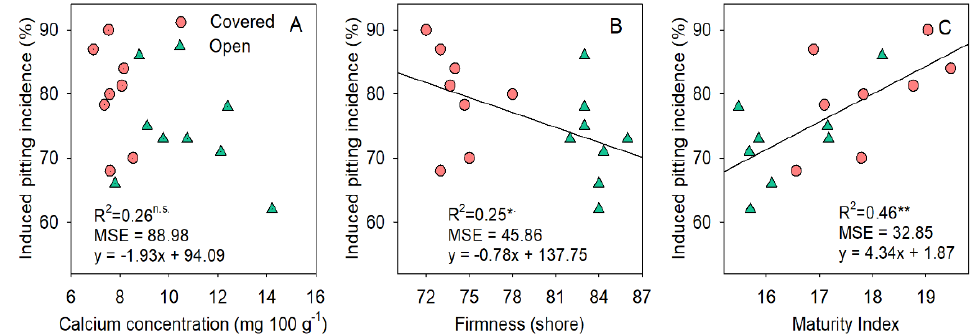
Figure 4. Relationships between induced pitting of ‘Santina’ sweet cherries from trees under high tunnels and those in the open in the Central Valley of Chile, season 2019/2020, after 14 d of cold storage, and Ca concentration ( A ), fruit firmness ( B ), and maturity index ( C ), at harvest. (n = 16). n.s.: not significant; * and ** correspond to the p -values ≤ 0.05 and 0.01; MSE: mean square error.